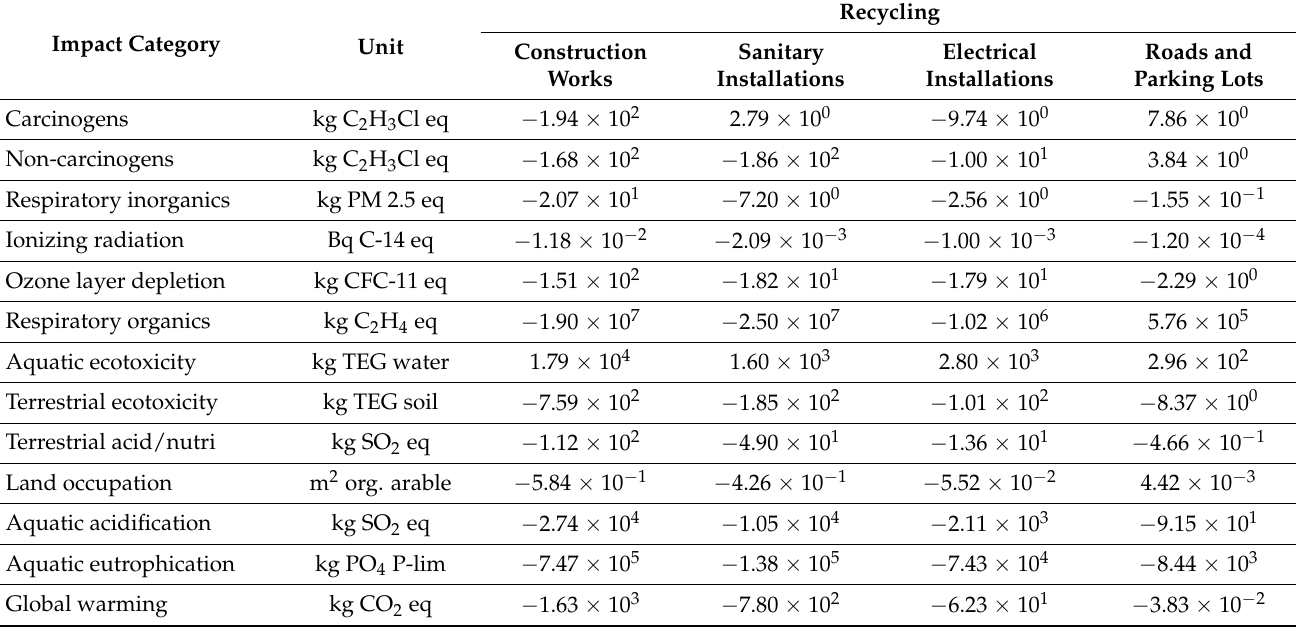
Table 7. The results of characterizing the environmental consequences occurring at the post-use development stage (in the form of recycling) of the research object by the groups of